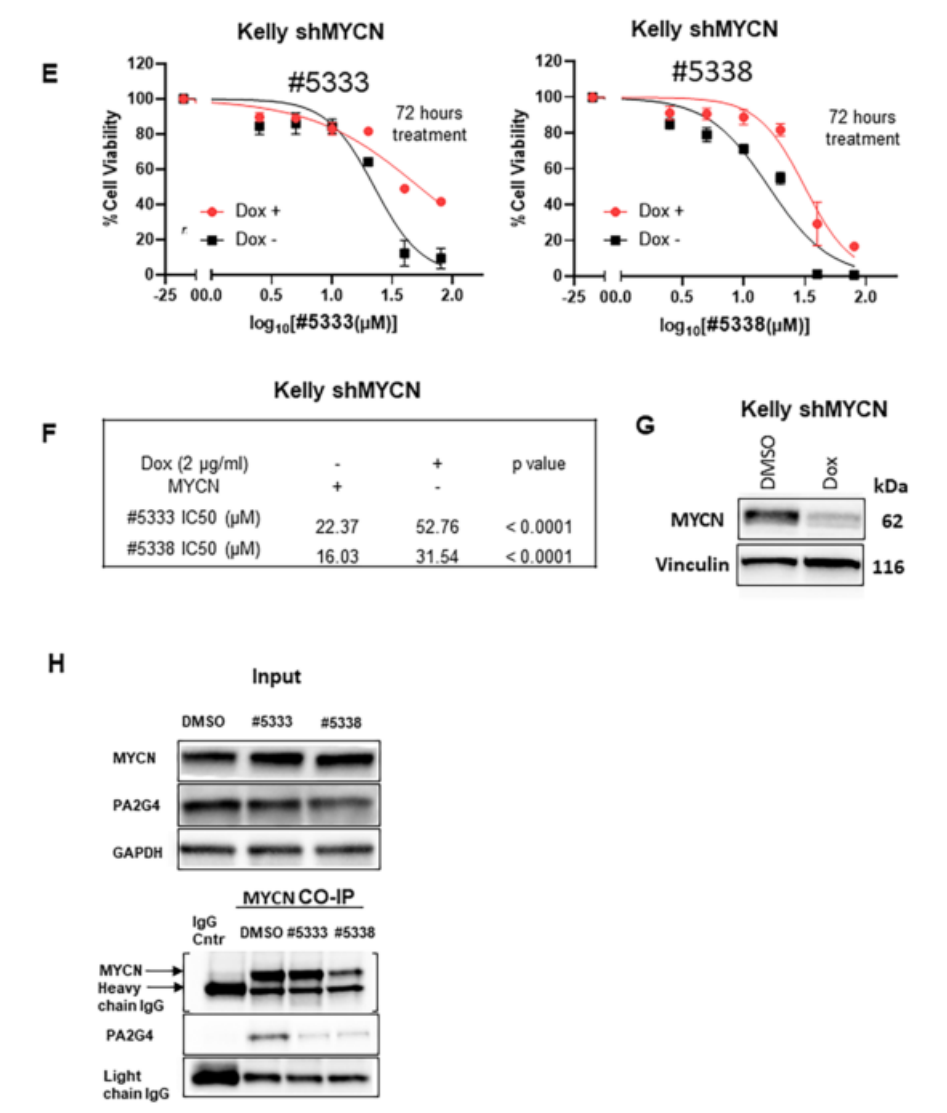
Figure 3. Compounds #5333 and #5338 functionally interact with MYCN and PA2G4 in neuroblastoma cells. ( A ) Western blot showing a decrease in protein expression due to #5333 or #5338 drug treatment. ( B ) Alamar Blue assays comparing cell viability of SK-N-BE(2)-C after Doxycycline (Dox)-inducible MYCN knockdown, followed by 72 h treatment with #5333 or #5338. ( C ) IC50s of Dox-inducible SK-N-BE(2)-C shMYCN cells treated with or without Dox and compound #5333 or #5338. ( D ) Western blot measuring MYCN expression in Dox-inducible SK-N-BE(2)-C shMYCN cells treated with DMSO or 2 µ g/mL of Dox for 96 h. ( E ) Alamar Blue assays in Kelly shMYCN comparing cell viability of Dox-inducible MYCN knockdown, followed by 72 h of #5333 or #5338 treatment. ( F ) IC50 values after 72 h of #5333 or #5338 treatment of the Dox-inducible Kelly shMYCN cell line. ( G ) Western blot measuring MYCN protein expression in Dox-inducible Kelly shMYCN cells treated with DMSO or 2 µ g/mL of Dox for 96 h. ( H ) A MYCN Co-IP analysis using protein from SK-N-BE(2) cells treated with compounds #5333 or #5338 treatment, and immunoblotted with antibodies recognising MYCN, PA2G4, GAPDH, or Light Chain IgG. The uncropped blots are shown in Supplementary Materials of original Western Blot